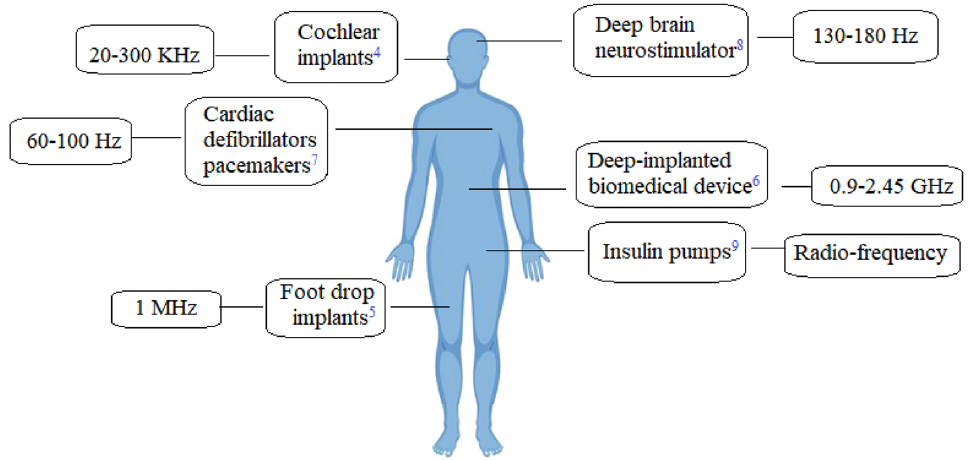
Figure 1. Some of the therapeutic implants which are supplied with WPT 10